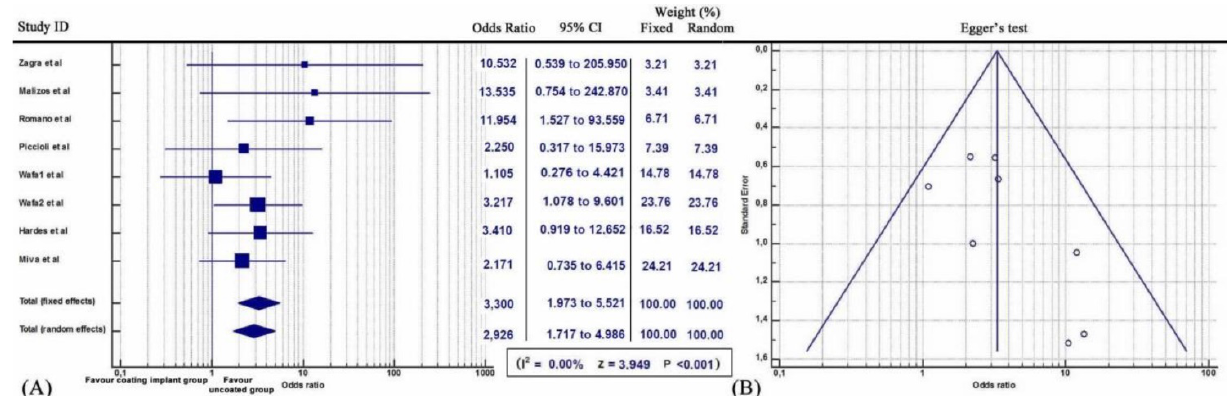
Figure 1. (A) Forest plot showing the likelihood of periprosthetic infections in the coating implant group versus the group without coating implants. (B) Funnel plot of the Egger’s test was utilized to assess for publication